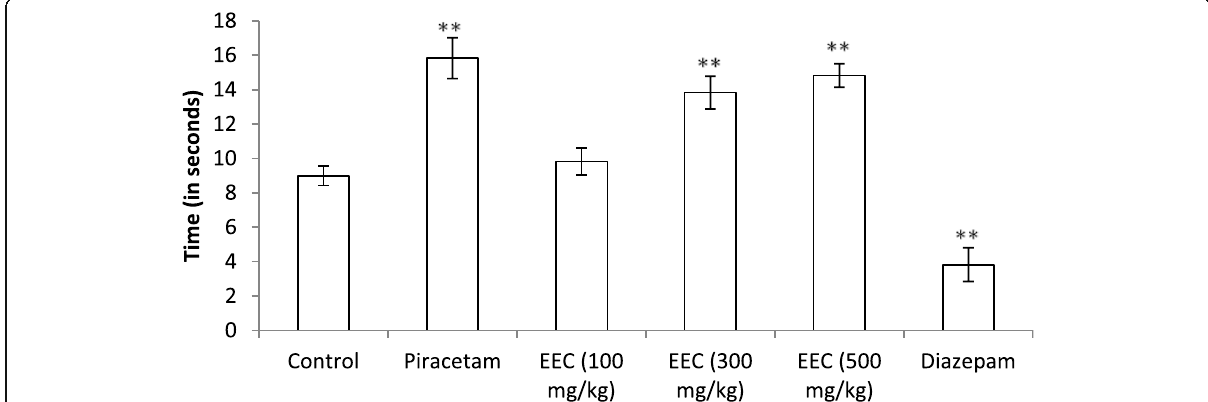
Fig. 3 Effect of EEC on discrimination index (DI) using object recognition taskAll values are mean ± SEM (n = number of animals in each group). Data was analyzed using one-way ANOVA followed by Dunnett test. *** p < 0.001, ** p < 0.01 and * p < 0.05 vs. normal control